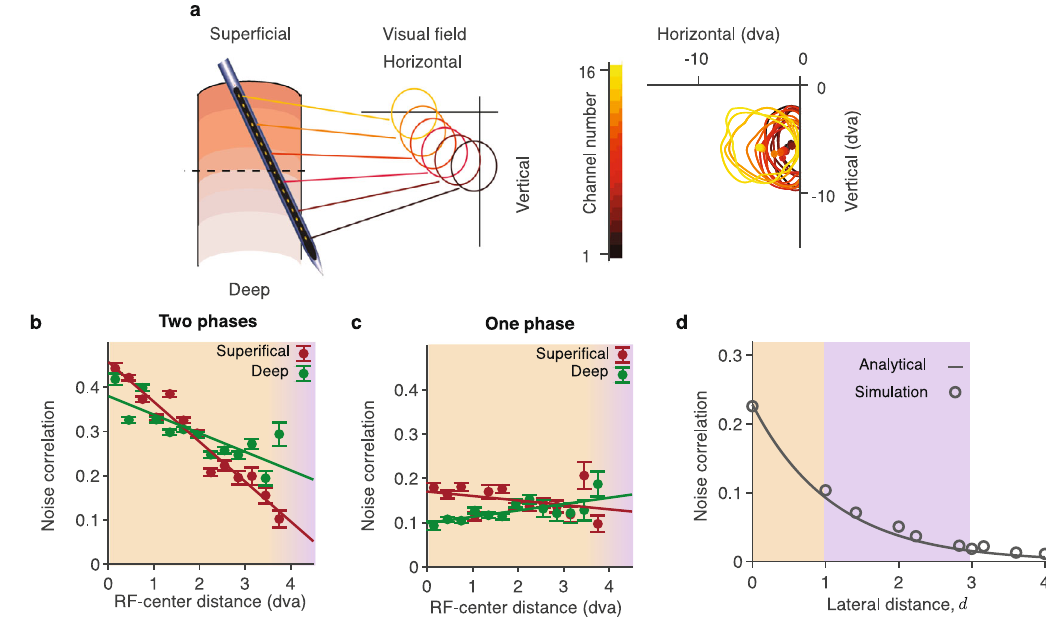
Fig. 4 Dependence of noise correlations on lateral distance. a Laminar recordings generally exhibit slight horizontal displacements which manifest in a systematic shift of the RFs (circles) across channels (left panel). The shift of the RFs (lines, RF contours; dots, RF centers; dva, degrees of visual angle) for an example recording (right panel). b In two-phase recordings, noise correlations decrease with the RF-center distance in both super fi cial (crimson) and deep (green) layers (dots - data points, lines - linear regression, super fi cial layers n = 2544 MU pairs; deep layers n = 3064 MU pairs). Orange background highlights the range of short lateral distances within single or nearby columns. Purple background highlights longer lateral distances between distant columns, such as distances covered by a Utah array, which are outside the range of our laminar recordings. Error bars represent the standard error of the mean (SEM). c Same as b for one-phase recordings. Noise correlations do not decrease with the RF-center distance (super fi cial layers n = 920 MU pairs; deep layers n = 1448 MU pairs). d Our theory predicts that noise correlations decay with lateral distance exponentially, with the decay constant L called correlation length. Simulations of the full dynamical-system network (circles) agree with the analytical formula derived using the binary-unit network approximation (line). The model parameters α 1 , α 2 , r on , and r off are sampled from a distribution of parameters in HMMs fi tted to the data. Source data are provided as a Source Data fi